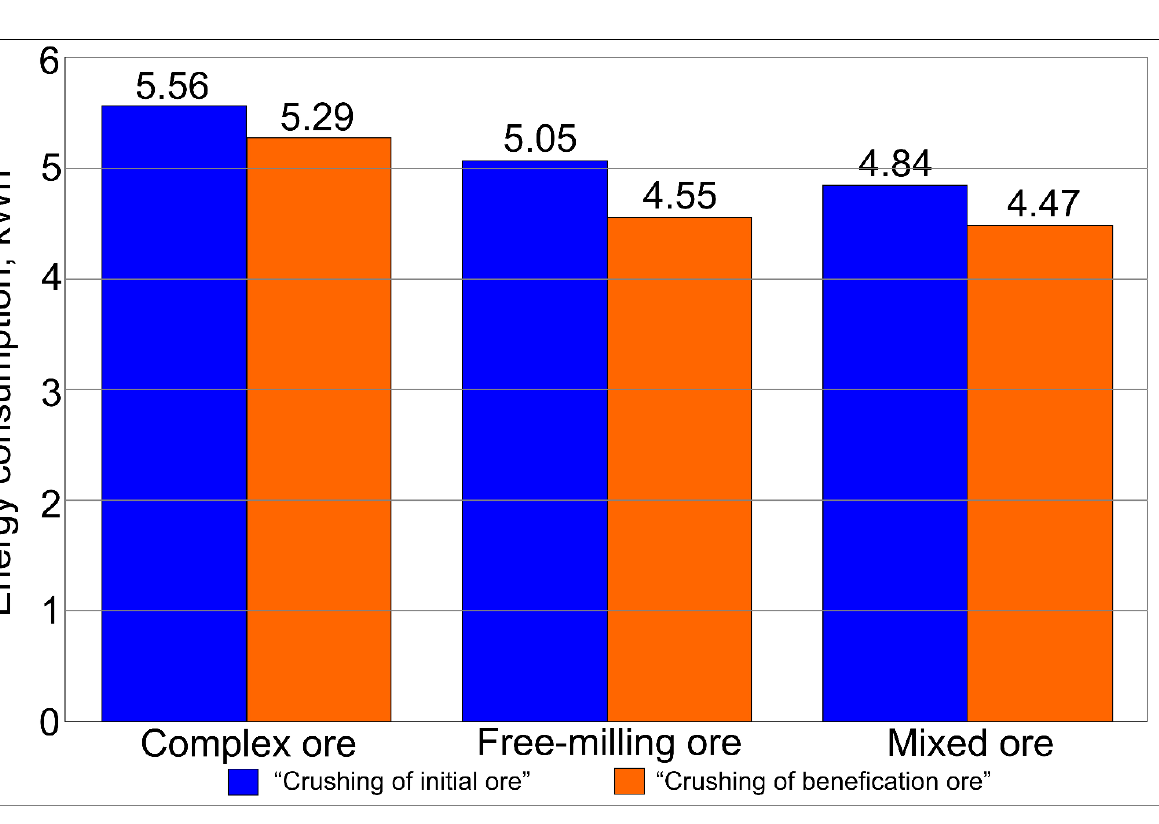
Table 8. Granulometric composition of the final crushing product.